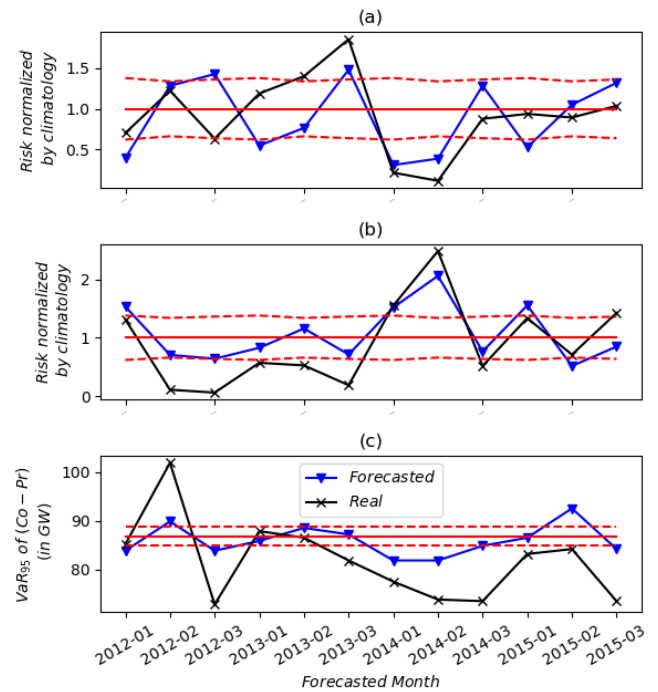
Figure 9. Monthly forecasted (blue) and real (black) risk relative to the climatology for winter months for ( a ) high consumption and low production ( R c + p − ) and ( b ) low consumption and high production ( R c − p + ) and ( c ) Extreme risk VaR 95 . Dashed red lines indicate significance levels at